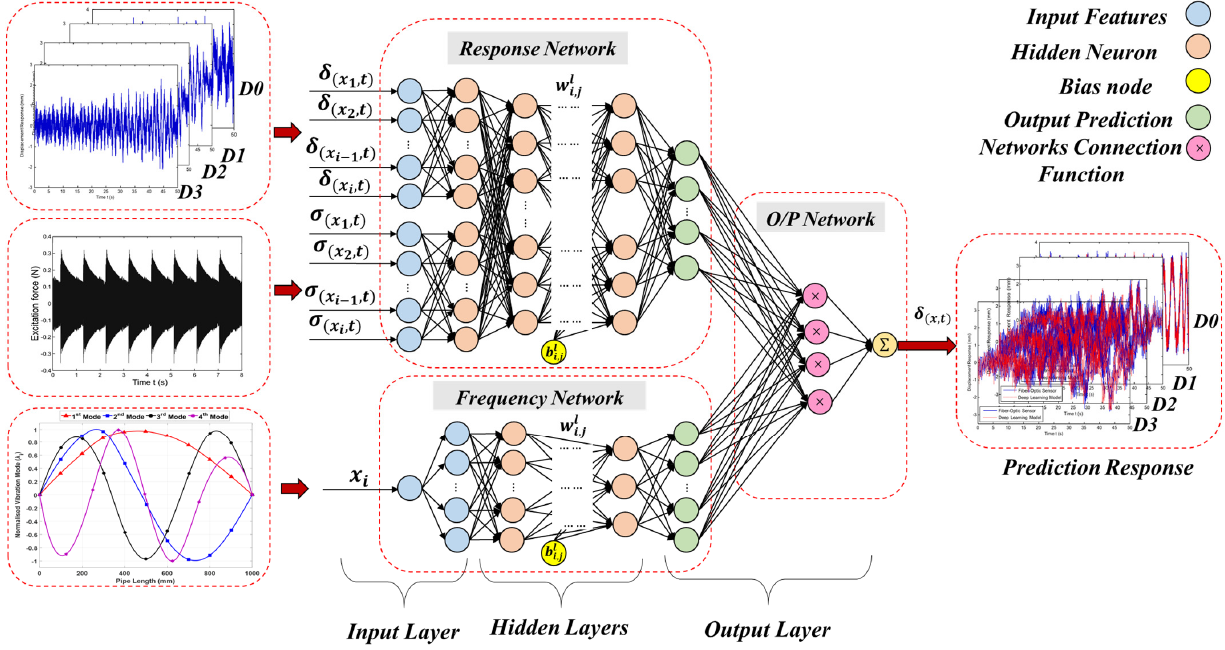
Figure 17. The architecture of the proposed ECNN for the response prediction.